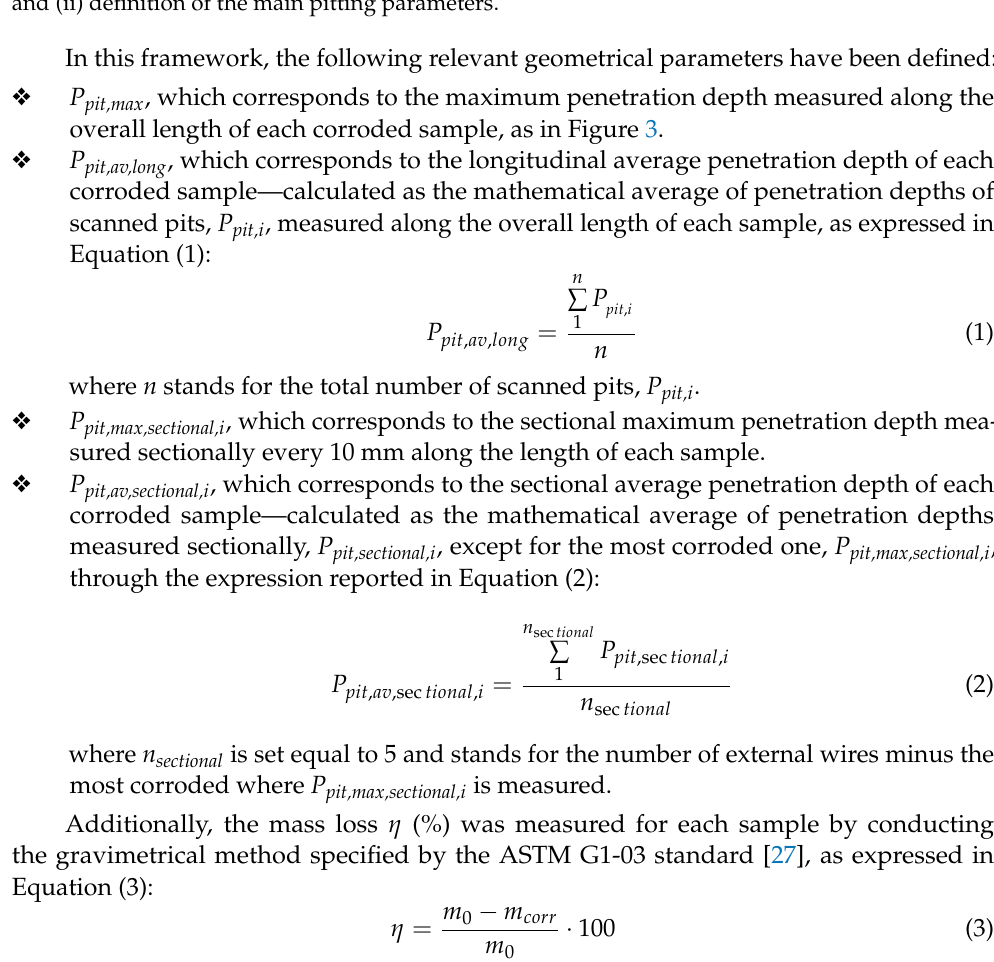
Figure 3. Example of 3D-model superimposition for the measurement of geometrical pitting parameters in the case of 250 mm long scanned length: (i) with a focus on sectional analysis every 10 mm and (ii) definition of the main pitting parameters.